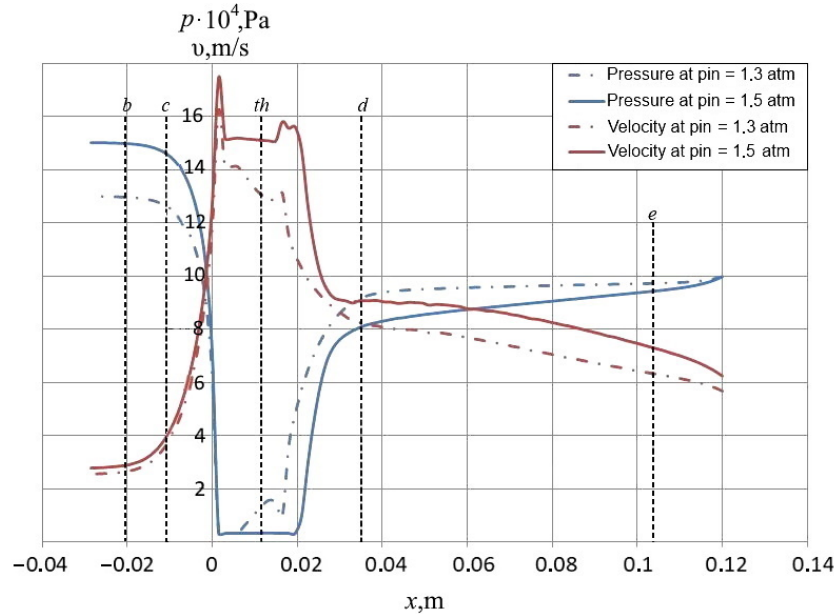
Figure 6. Absolute pressure p abs and flow velocity υ along the Venturi tube (from our CFD results). When inlet pressure is increased to p in = 1.5 atm cavitation zone is propagating further to diffuser (Figure 5c,d). Based on Figures 3 and 6, four points were selected for calcula- tions of p abs , υ and σ . Results for the calculated cavitation number σ are shown in Tables 1 and 2. Table 1. Absolute pressure and velocity (in atm. and m/s) (from our CFD results). Nozzle and Flow Direction σ pa , υ th σ pb , υ th σ pb , υ b σ pc , υ th